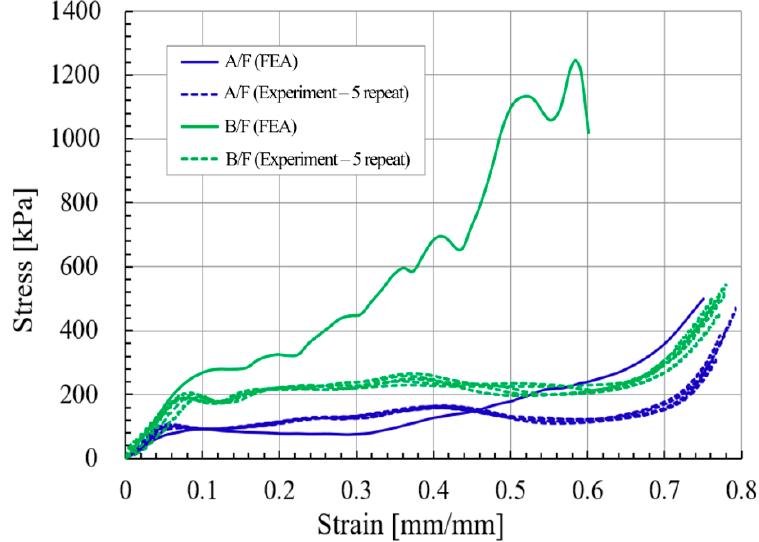
Figure 7. Comparison of the SS curves of the SW corrugated paperboard acquired through experi- ments and